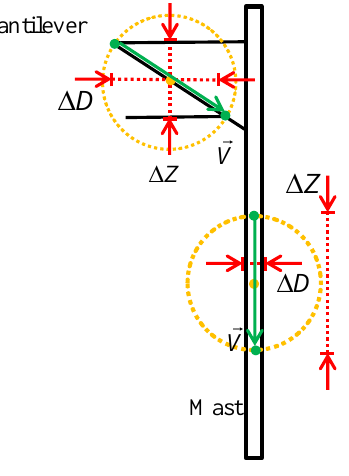
Figure 11. In contrast to points on cantilevers, neighbourhoods of points on masts are vertically distributed. Orange points and circles represent query points and their 3D spherical